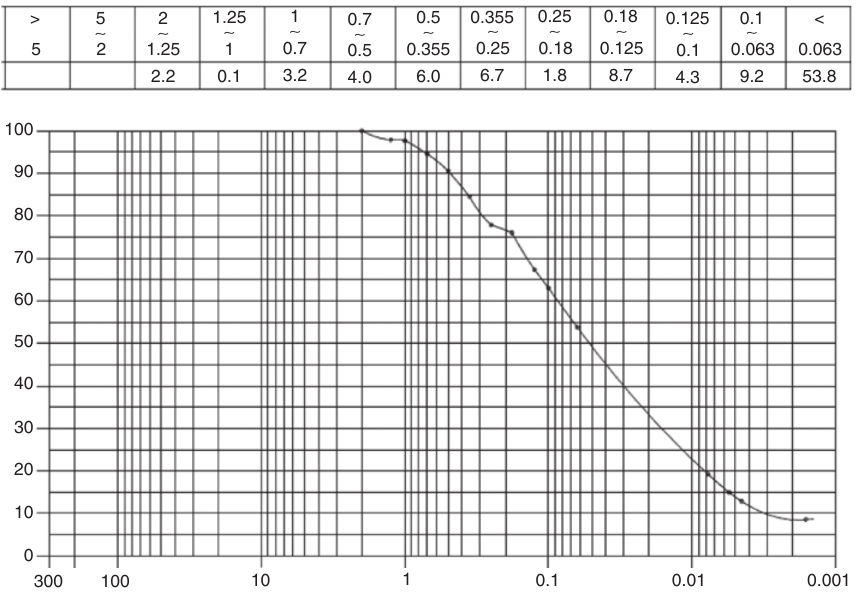
) (artificial soil). 3 2